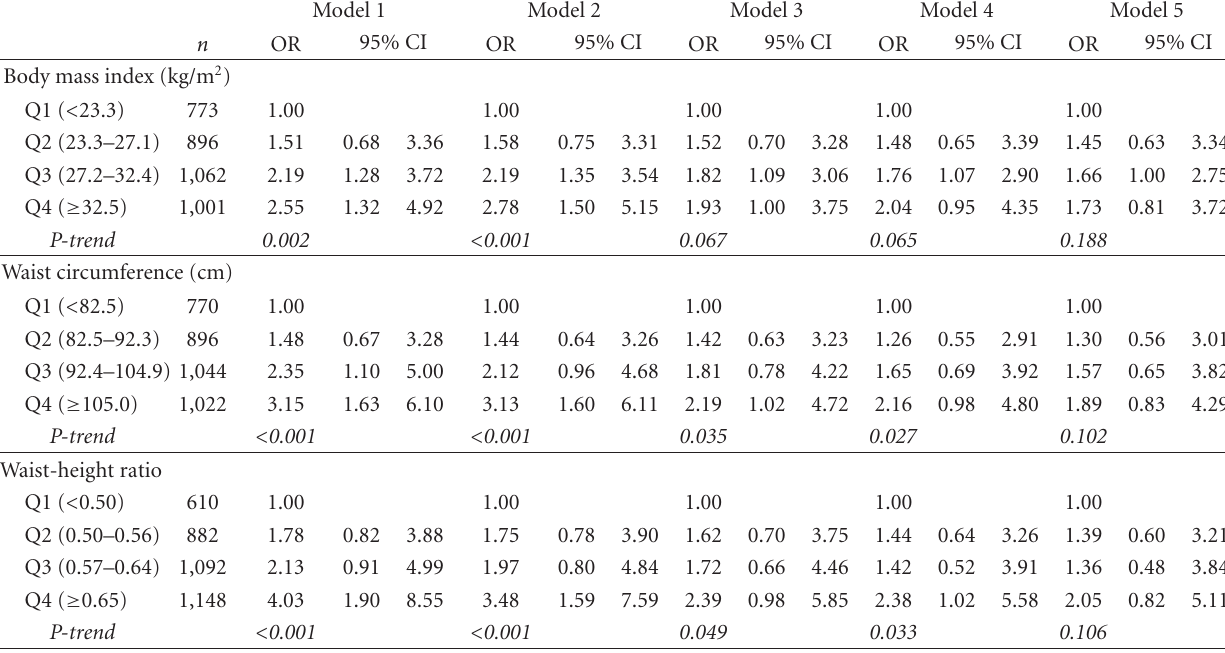
Table 2: Odds ratios with 95% confidence intervals for suicidal ideation among US women aged ≥ 20 years by quartiles of BMI, waist circumference, and waist-height ratio, NHANES 2005–2008 ( n =